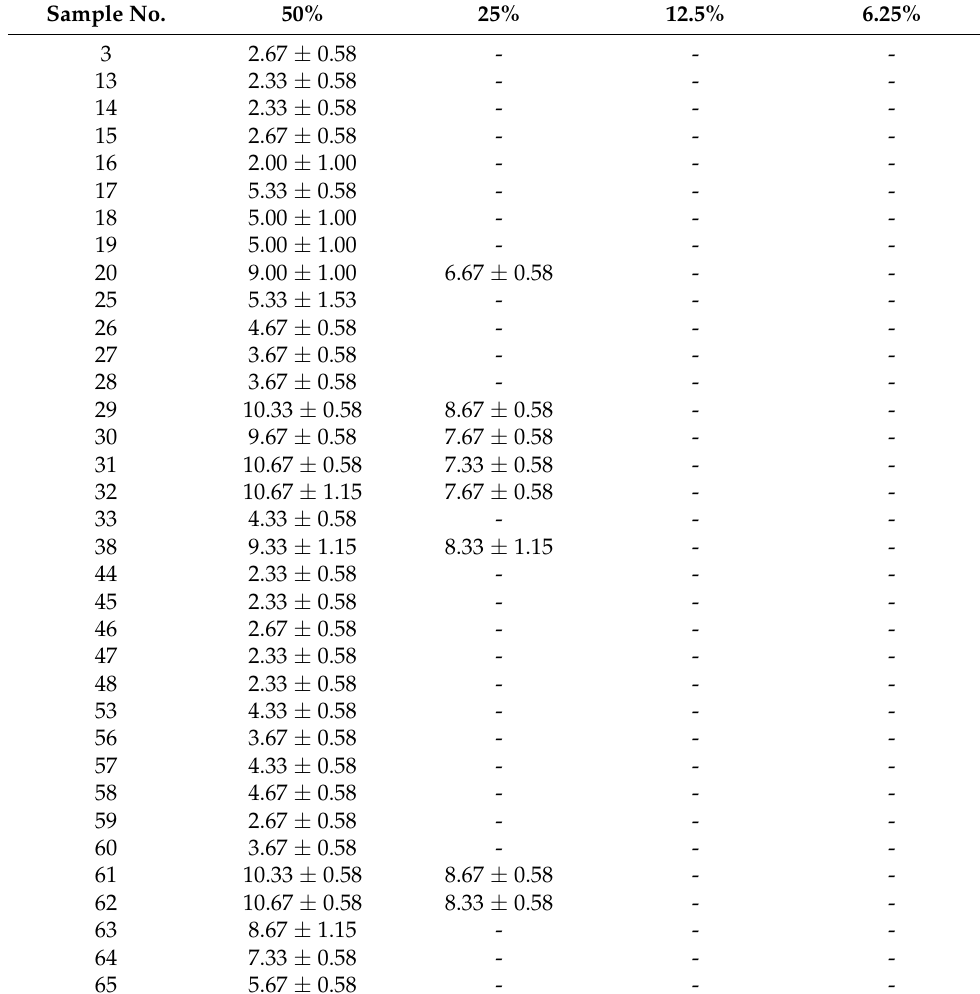
Table 2. Antimicrobial activity of samples against Y. enterocolitica in mm. Sample